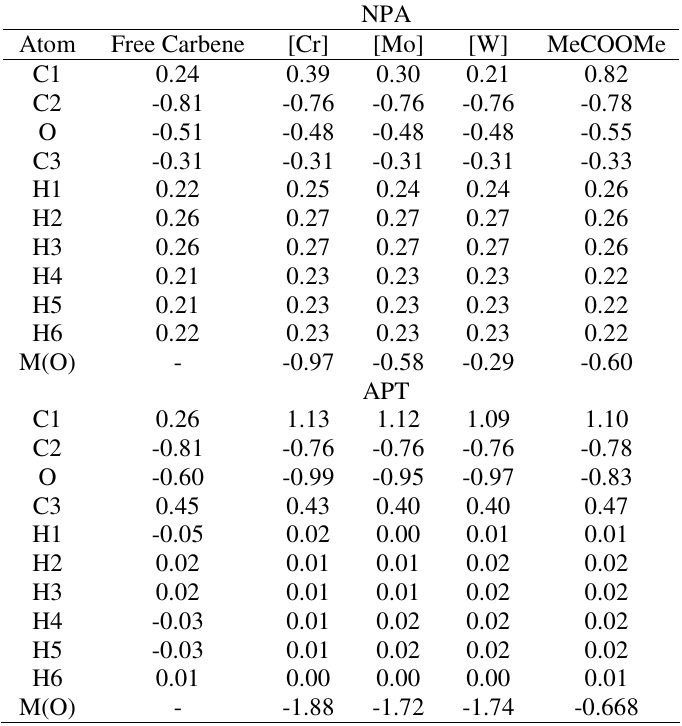
Table 3 . The NPA and APT atomic